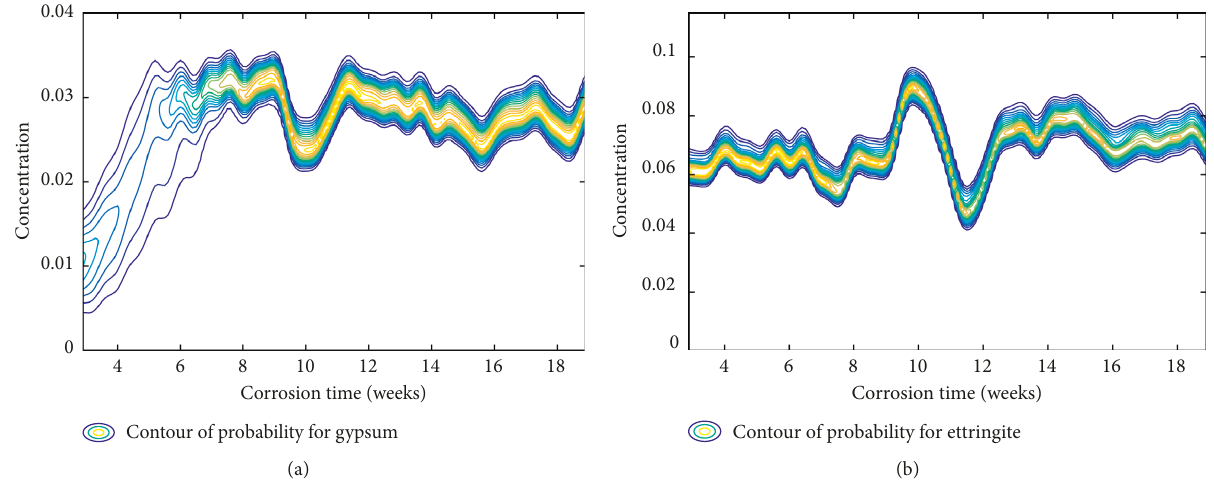
Figure 11: Probability contours of the concentrations of (a) gypsum and (b)